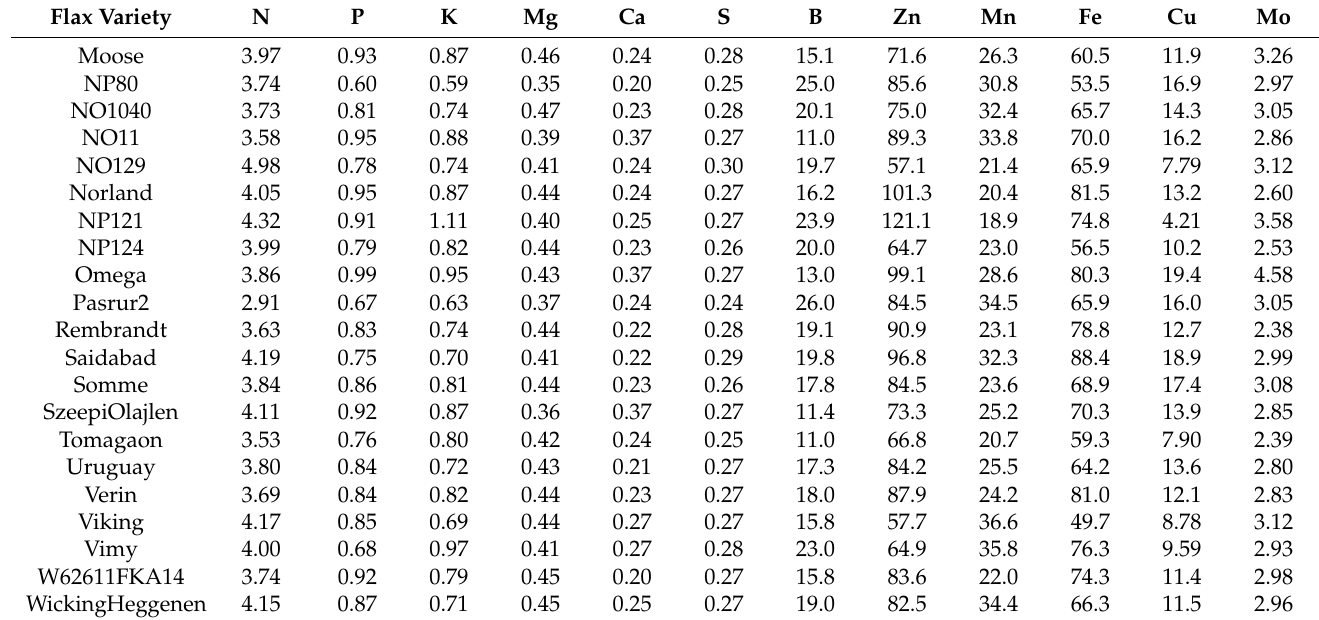
Table 2. Mean elemental concentrations of 108 sorghum varieties as % (N, P, K, Mg, Ca, and S)